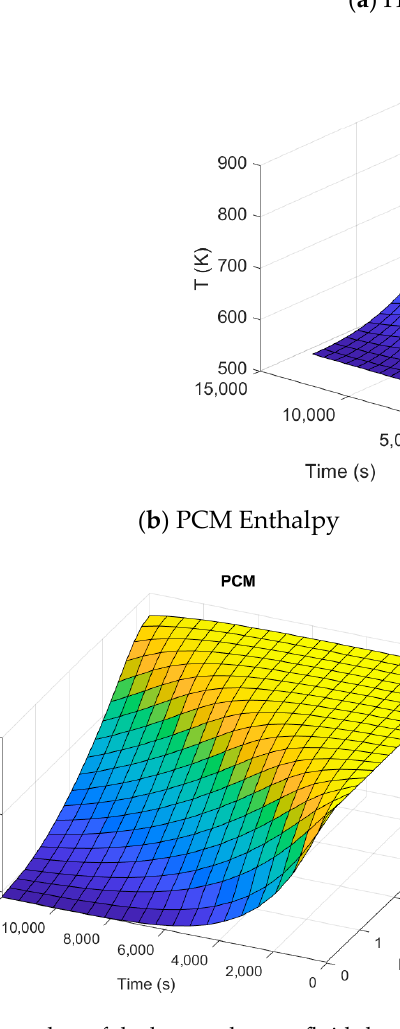
Figure 8. Surface plots of the heat exchanger fluid-dynamic simulation increasing the height of the PCM encapsulated bed up to 4.4m: HTF temperature ( a ), PCM enthalpy ( b ), and PCM temperature ( c ) as a function of discharging time and heat exchanger height.